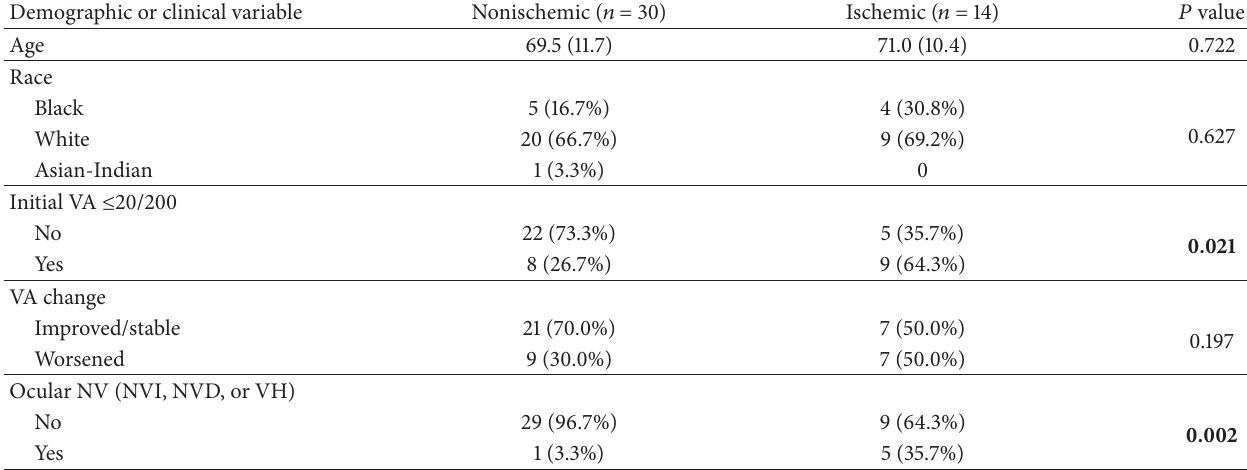
Table 1: Demographic and clinical features of patients with ischemic and nonischemic CRVO receiving anti-VEGF for macular edema.